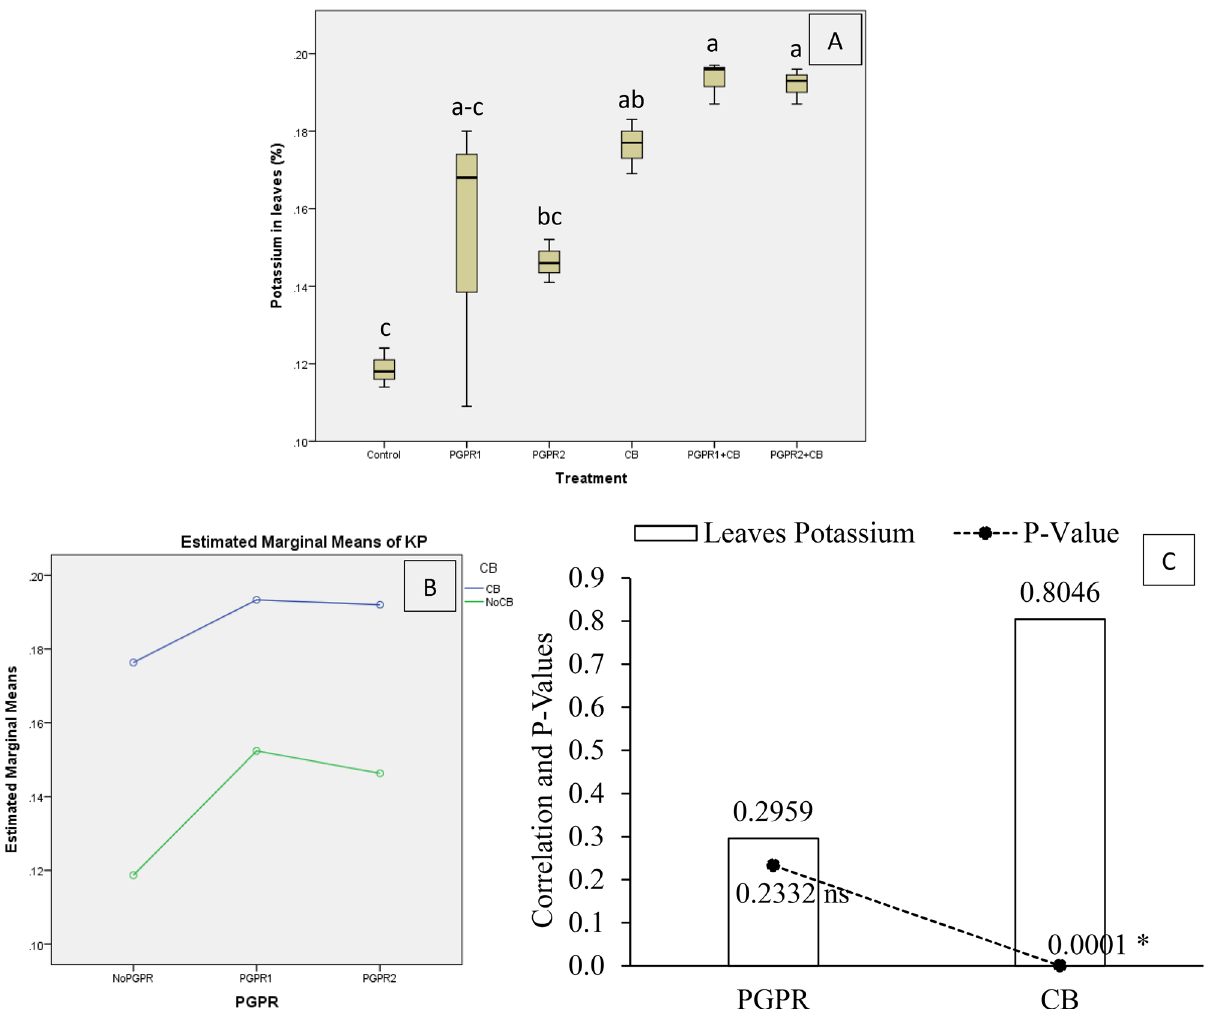
Figure 14. Effect of treatments on mint plants leaves potassium concentration (KP). Values are the average of three replicates ( A ). Different letters showed significant differences (Tukey’s test; p ≤ 0.05). Interaction graph of PGPR and CB for KP ( B ). Correlation graph of PGPR and CB for KP ( C